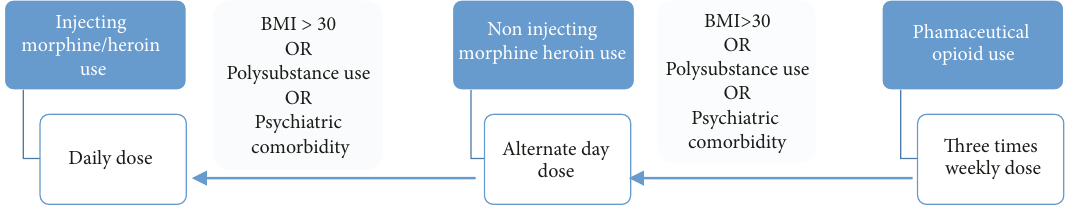
Figure 1: Dose assignment and